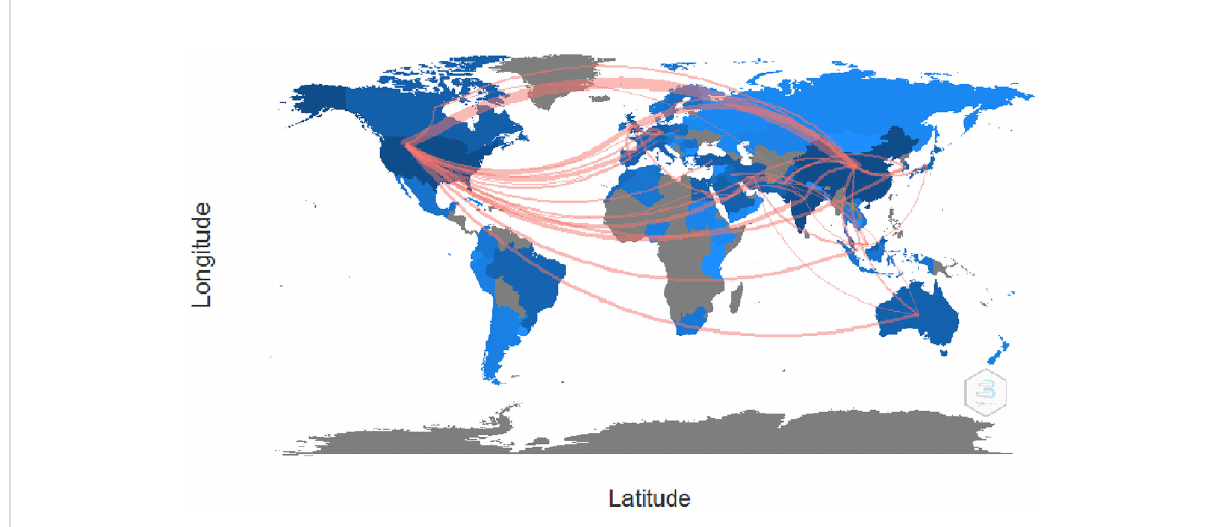
FIGURE 10 Pictorial representation of the countrywide collaboration using the country collaboration